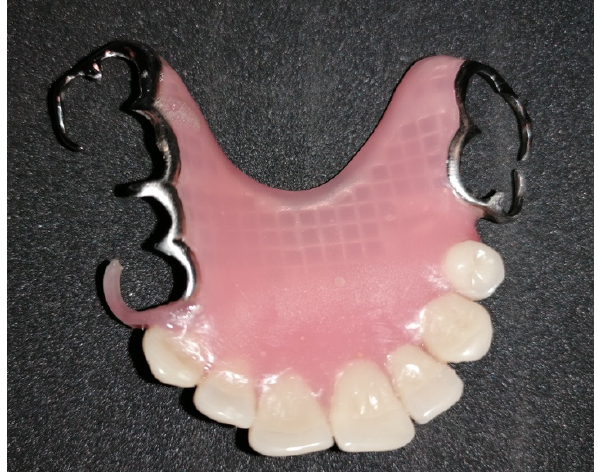
Figure 9. Mobile dental prosthesis with an anchoring system to the lateral teeth of the surgical